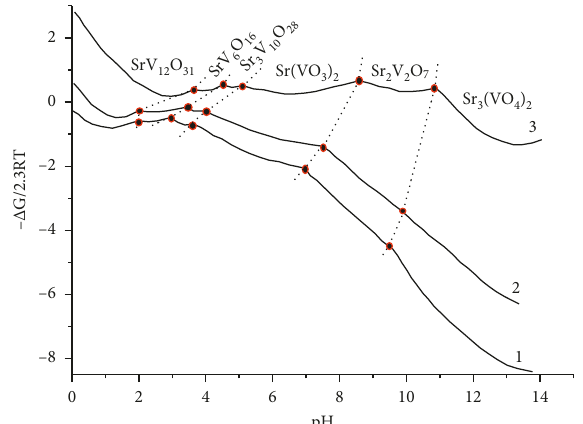
Figure 4: Δ G S versus pH for different SrO-V 2 O 5 -H 2 O systems: (1) C V � C Sr � 1mol · L − 1 ; (2) C V � C Sr � 1 × 10 − 1 mol · L − 1 ; (3) C V � C Sr � 1 × 10 − 3 mol · L − 1 .